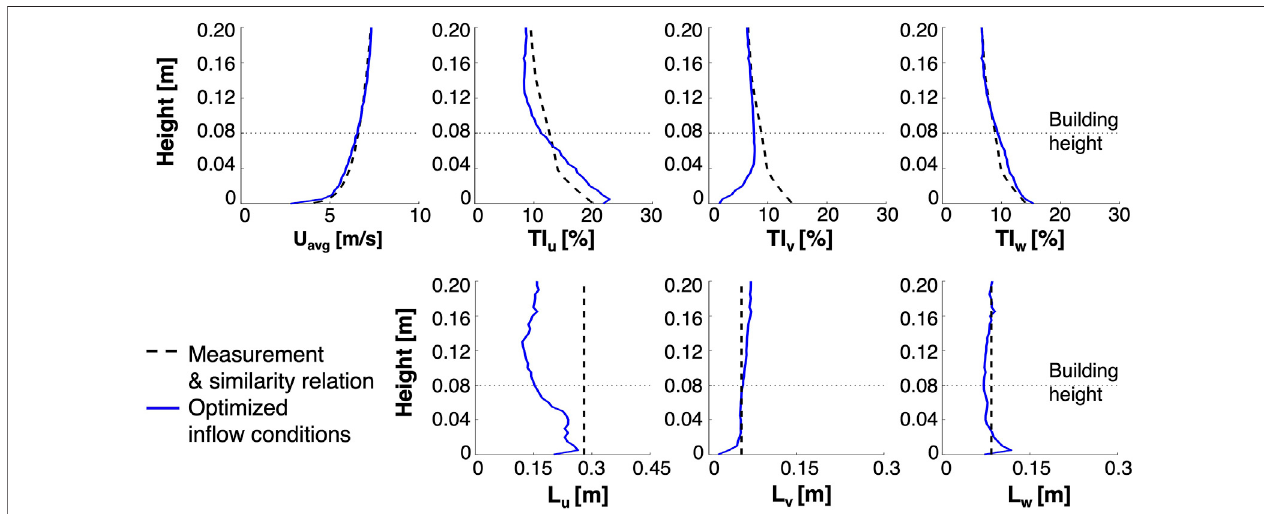
FIGURE 2 | Mean velocity, turbulence intensity, and length scale pro fi les: target pro fi les (black dashed line) and pro fi les obtained at the building location using the optimized in fl ow pro fi les (blue solid line).